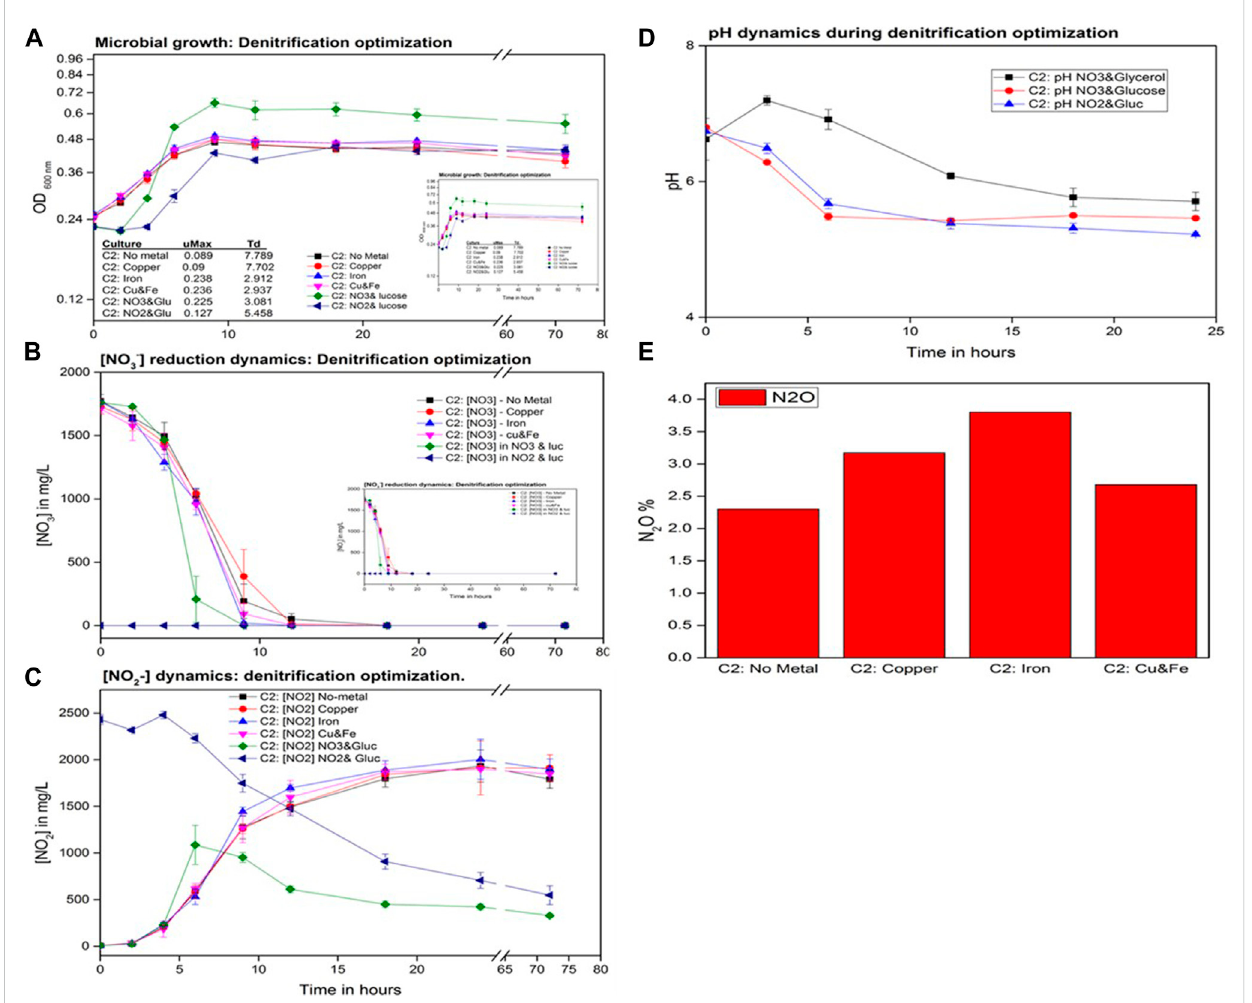
FIGURE 4 Metal kinetics data. (A) Microbial growth curves, (B) nitrate reduction progress curves, (C) nitrite production curves, (D) pH changes in the cultures, and (E) nitrous oxide percentages in biogenic gases.